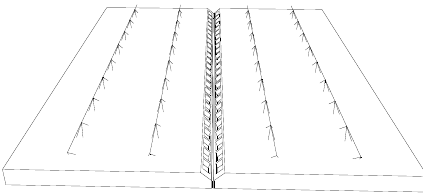
Figure 11. Top view of seam position of CLHCPCS.